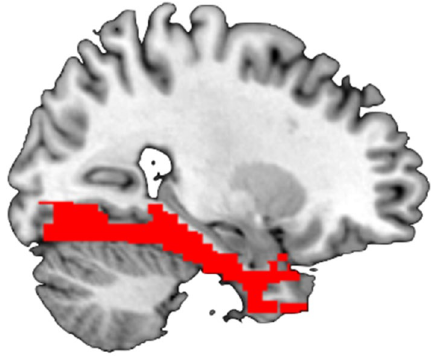
Figure 7. Brain image with the ROI. ROI used in this experiment was a mask of parahippocampal gyrus and fusiform gyrus, as shown in red in this brain